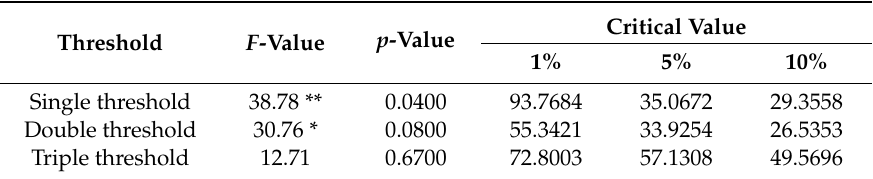
Table 2. Test results of threshold significance.